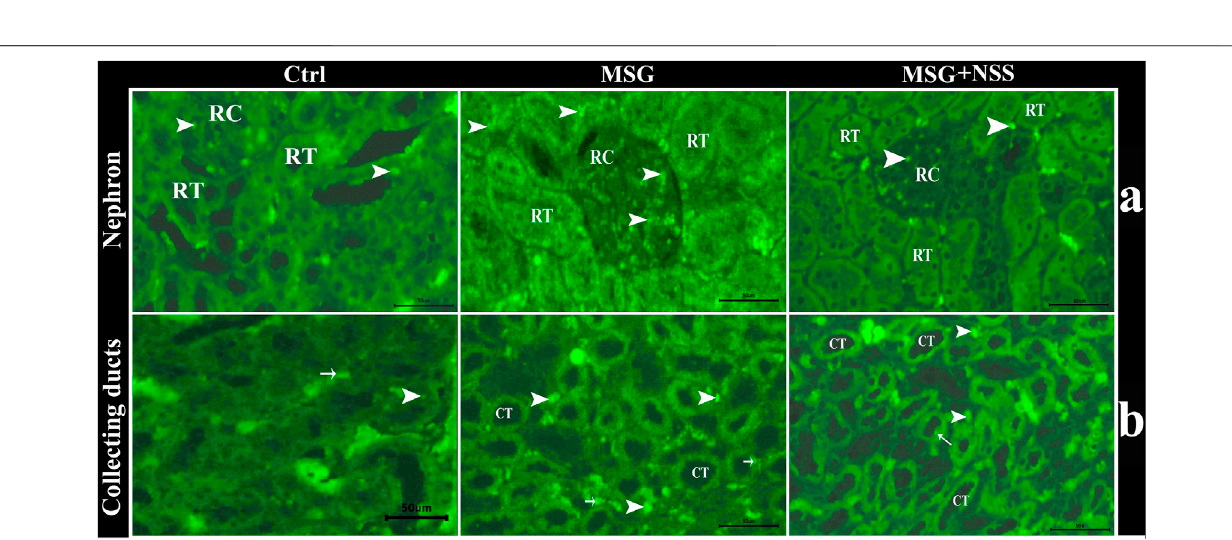
Frontiers in Pharmacology |